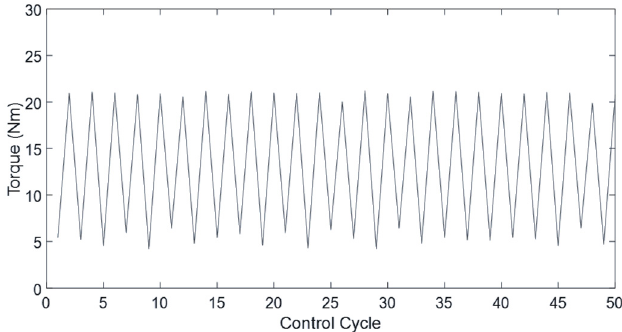
Figure 14. The third torque variation term for proposed rSVM-DTC (10 kHz).